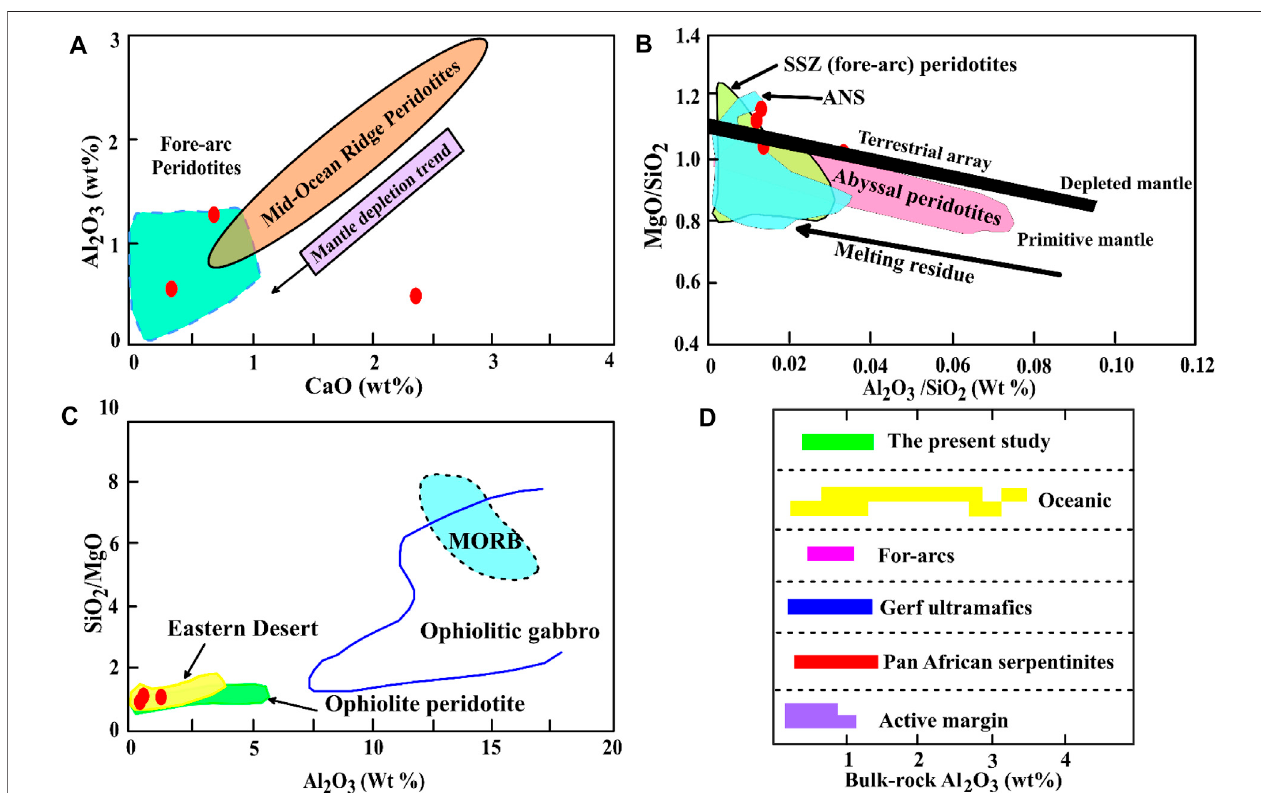
FIGURE 8 | (A) CaO versus the Al 2 O 3 diagram showing KUS serpentinites compared with forearc and MOR peridotites (Ishii et al., 1992). (B) MgO/SiO 2 versus Al 2 O 3 /SiO 2 diagram. Primitive and depleted mantle values are from McDonough and Sun (1995) and Salters and Stracke (2004), respectively. The “ terrestrial array ” represents thebulk silicate Earthevolution (Jagoutz et al., 1979; Zindler and Hart, 1986).Fields ofabyssal and forearc peridotites are after Parkinson and Pearce (1998), Pearceetal.(2000),andNiu(2004).ANSophioliticperidotite fi eldisafterAhmedandHabtoor(2015)andAbdel-Karimetal.(2018). (C) SiO 2 /MgOratiosversusthe Al 2 O 3 diagram. Fields of ophiolitic gabbros and peridotites, as well as MORB are from Bodinier and Godard (2003). Data from the Eastern Desert are shown for comparison by Zimmer et al. (1995); Azer and Khalil (2005), Azer and Stern (2007), Azer et al. (2013), Abdel-Karim et al. (2016) and Abdel-Karim et al. (2018). (D) Bulk- rock Al 2 O 3 (wt%) contents of Tilal Al-Qulieb serpentinites compared with those from different tectonic settings and the Pan-African serpentinites.